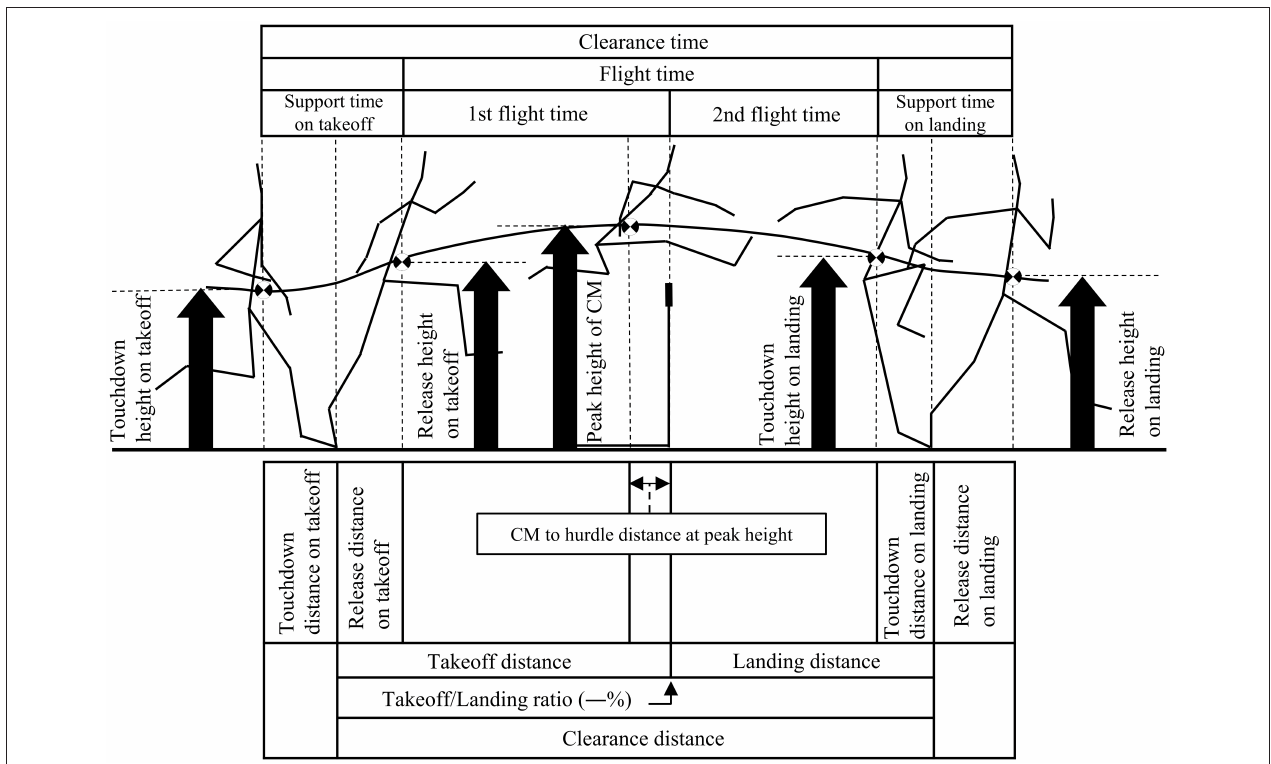
FIGURE 1 | Spatiotemporal variables of hurdle clearance examined in this study. Adapted from Ozaki and Ueda (2021). Takeoff/Landing ratio: The takeoff distance divided by clearance distance. CM to hurdle distance at peak height: The horizontal distance between the hurdle and the CM at the peak height of the CM. The direction toward the front of the hurdle was defined as positive, and that toward the back of the hurdle was defined as negative. The above-mentioned spatial variables (CM height) were divided by the CM height of each participant and multiplied by 100 for analysis. The above-mentioned spatial variables (horizontal distance) were divided by the height of each participant and multiplied by 100 for